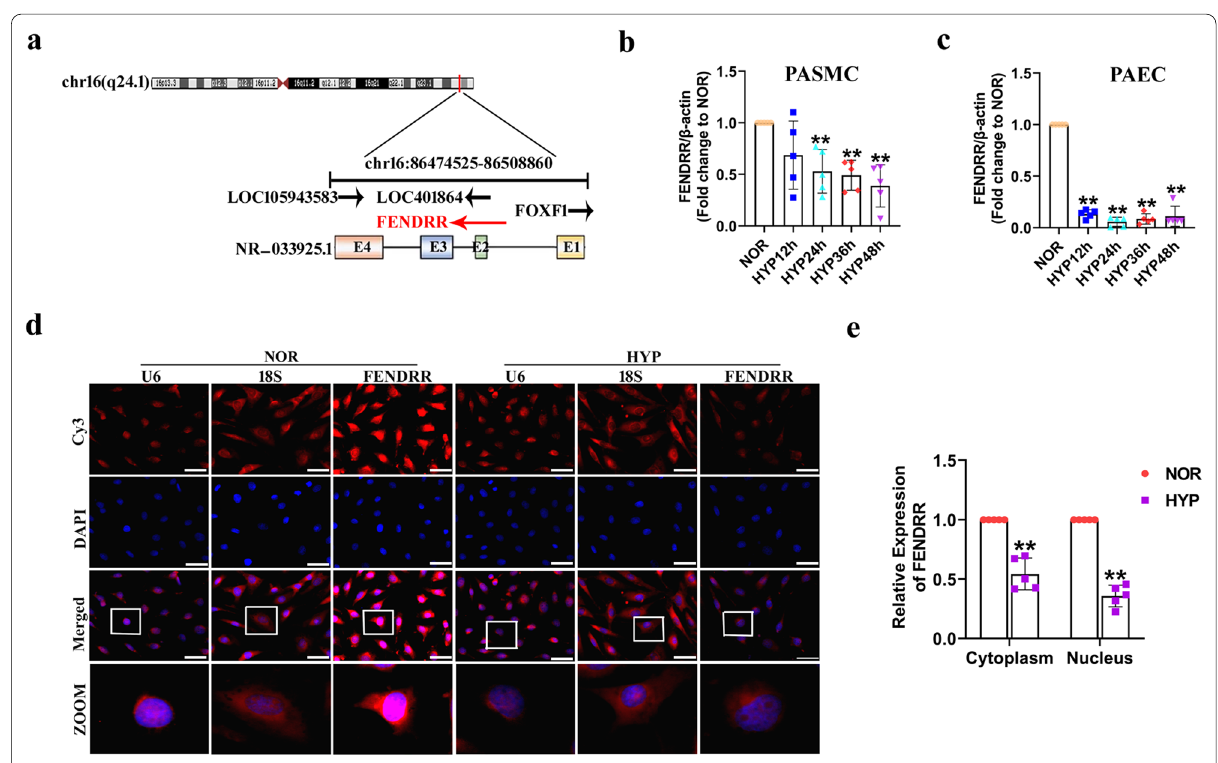
Fig. 1 FENDRR expression is decreased under hypoxic conditions. a Genomic location of FENDRR. The arrows indicate the direction of transcription. b Expression of FENDRR quantified by qRT-PCR in human pulmonary artery smooth muscle cells endothelial cells (HPASMCs) (n 5). c Expression = of FENDRR quantified by qRT-PCR in human pulmonary artery endothelial cells (HPAECs) (n 5). d HPAECs were cultured for 24 h under HYP = conditions, and fluorescence in situ hybridization (FISH) assay was performed to detect FENDRR expression. U6 and 18S RNA were used as controls for localization of the nucleus and cytoplasm. Scale bar 50 μm. e FENDRR expression in the nucleus and cytoplasm of HPAECs after exposure = to HYP for 24 h (n 5). Each datapoint in the figure represents a unique biological replicate. All values are presented as the mean SD. Statistical = ± analysis was performed with Student’s t-test. NOR: normoxia; HYP: hypoxia. **P < 0.01 compared with